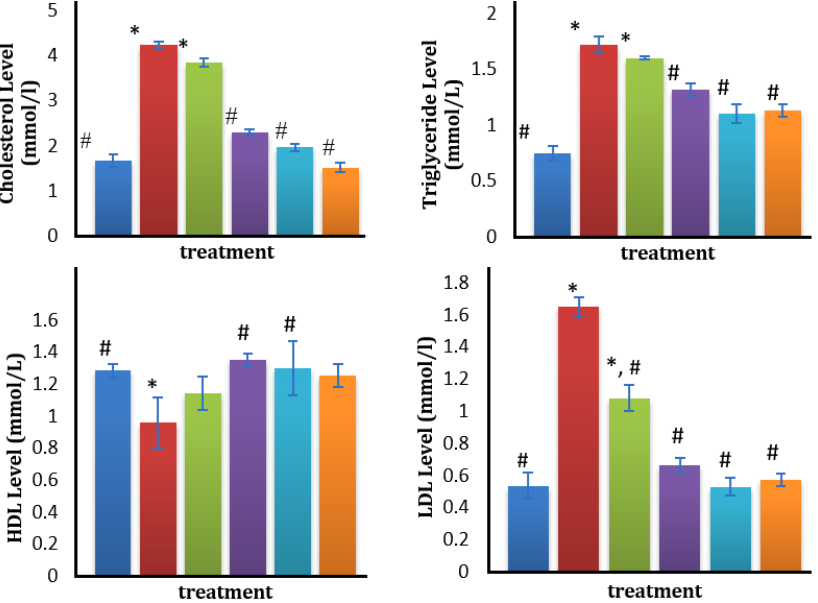
Figure 2 Effect of MPMTE on (a) cholesterol, (b) triglycerides, (c) HDL, and (d) LDL levels. The lipid profile of normal rats and STZ-induced diabetic rats were measured at the end of the study. The values are mean ± SEM (n=6/ group). *vs normal control; #vs untreated diabetes ( p < 0.05, One Way ANOVA followed by post hoc Duncan